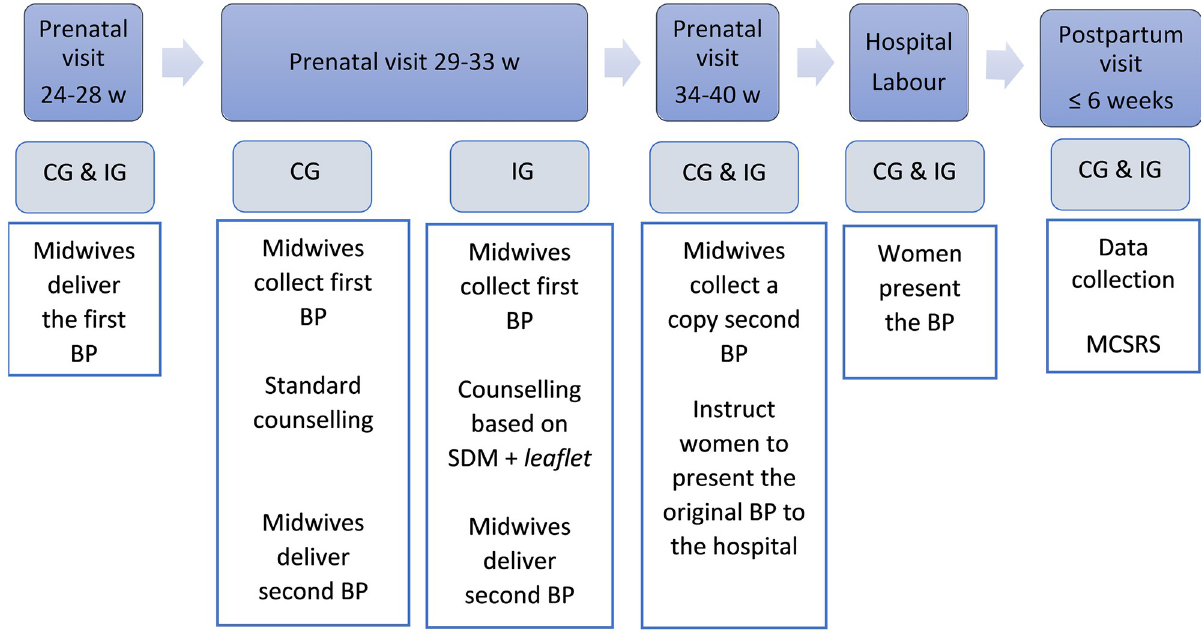
Fig 1. Intervention characteristics and follow up of the pregnant women. W = weeks; CG = control group; IG = intervention group; BP = birth plan; SDM = shared decision making; MCSRS = Mackey Satisfaction with Childbirth Rating Scale.